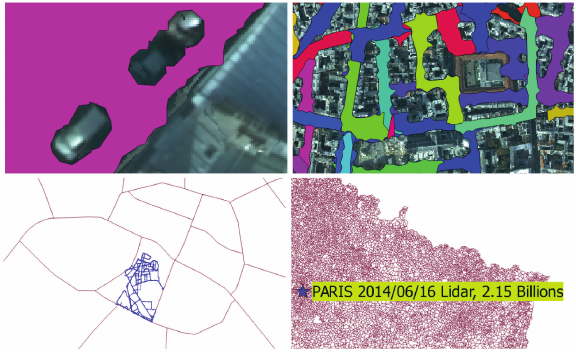
Figure 7: Successive visualisations of point cloud coverage, see